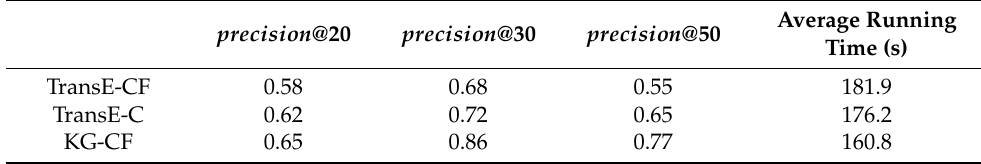
Table 6. precision @ K